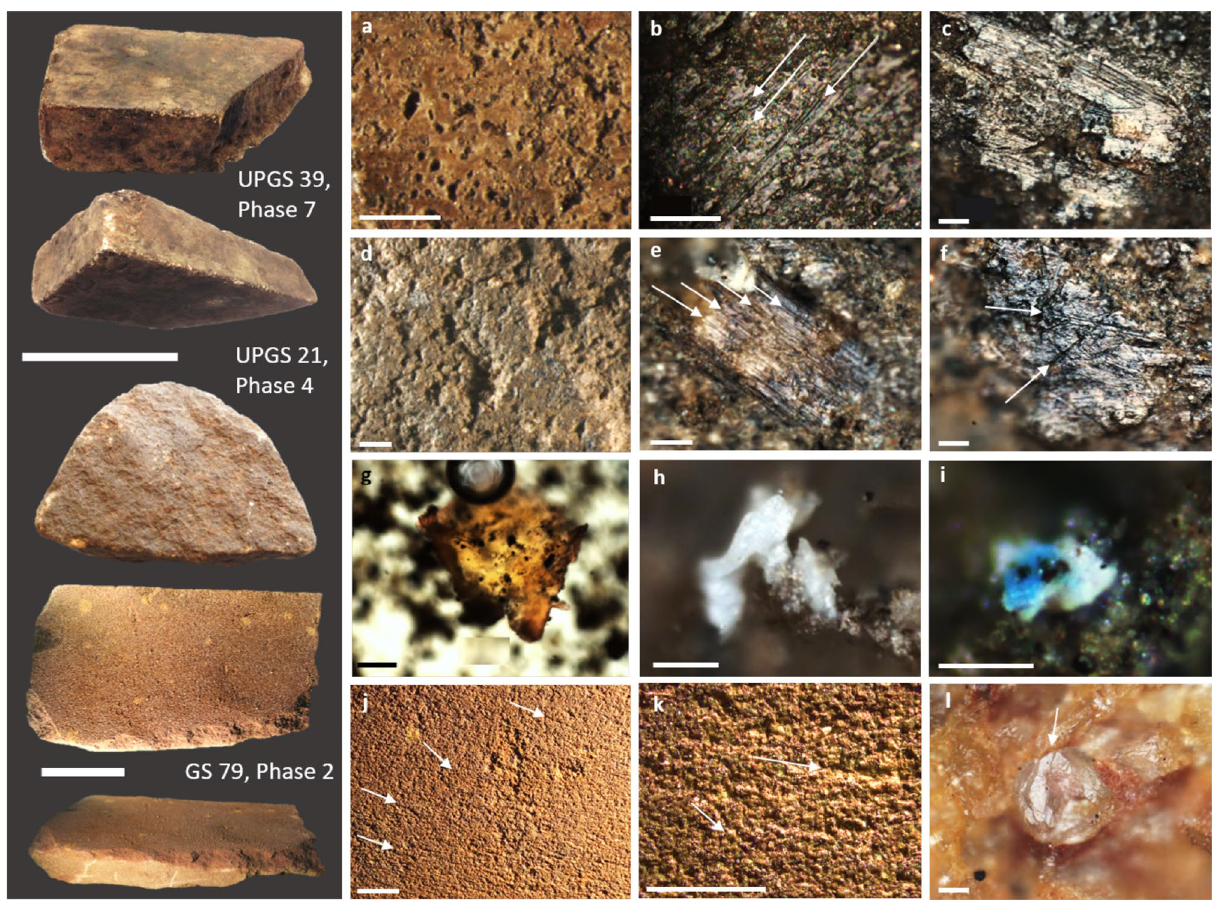
Figure 4. Examples of stone and bone files from Madjedbebe: UPGS39 from Phase 7, UPGS21 from Phase 4 and GS79 from Phase 2. ( a ) levelled surface of UPGS 39; ( b ) use-polish on the more elevated zones of the stone micro-topography with numerous striations on UPGS39; ( c ) metal residues with evident smearing and directionality on UPGS39; ( d ) levelled grains on the surface of UPGS21; ( e , f ) striated (arrows) and undulating use-polish on UPGS21; ( g ) collagen tissue stained with Orange G from pipette extraction sampled from UPGS21; ( h ) organic residue cf. bone on UPGS21; ( i ) white residue with blue mineral secretion, cf. bone and vivianite, on UPGS21; ( j , k ) surface of GS79 with removed grains and surface striations/scratches; ( l ) quartz grain on the surface of GS79, note that the grain is fractured (arrow) from contact with a hard material (e.g., stone). Scale bars for artefact images are 5 cm; scale bars for low magnification images are 1 mm; scale bars for high magnification images are 0.05 mm image i. is 0.02